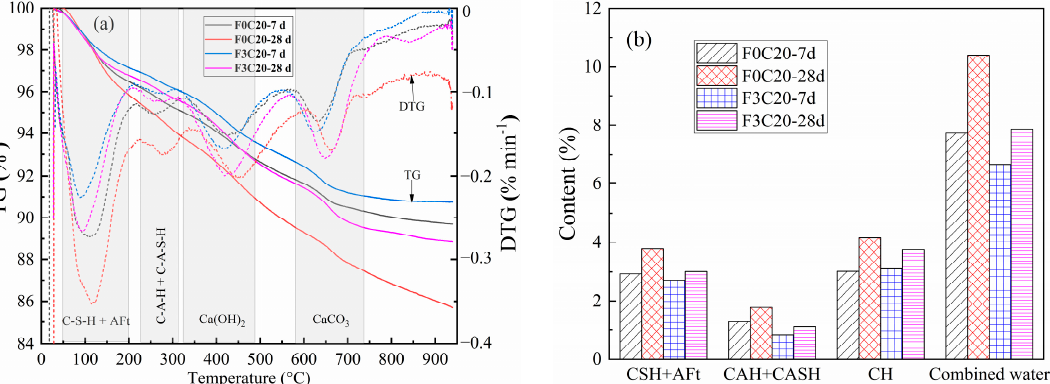
Figure 10. TGA results of F0C20 and F3C20: ( a ) TG and DTG curves; ( b ) the amount of